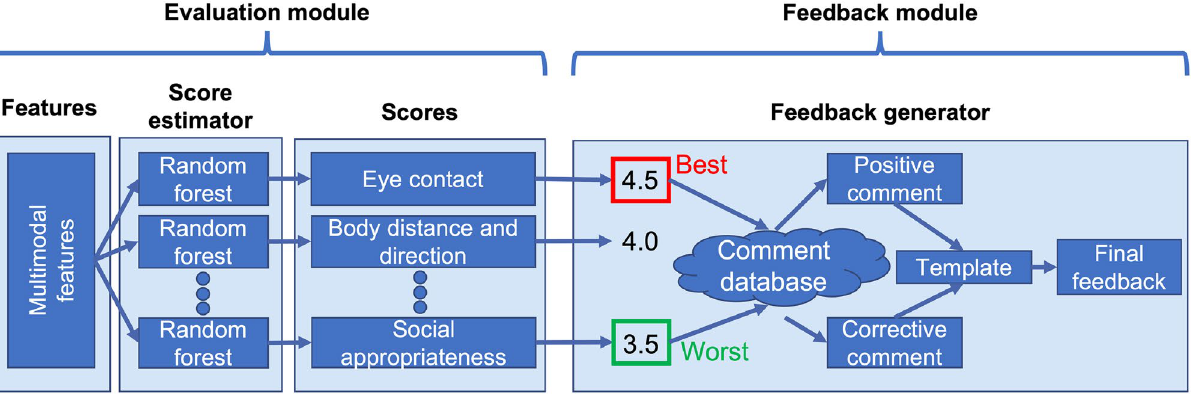
Figure 1. Schematic of our evaluation-feedback pipeline of social skill